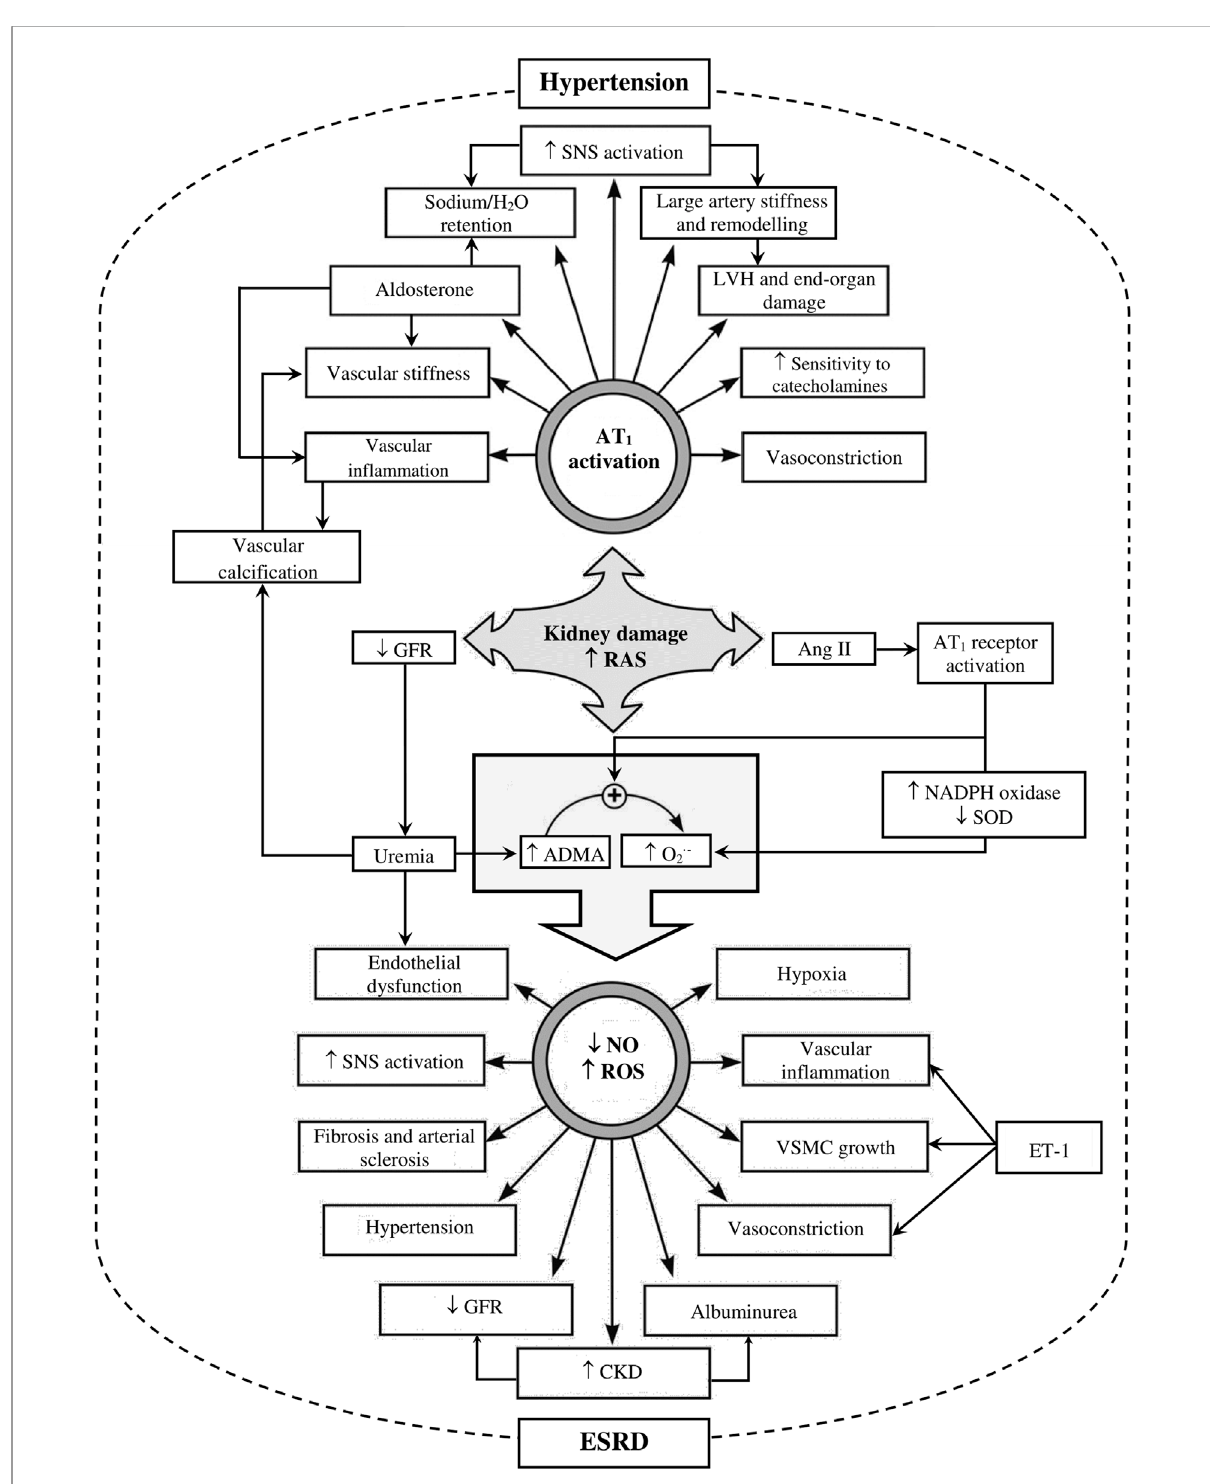
FIGURE 1 Schematic representation of factors involved in kidney damage, hypertension and end-stage renal disease (ESRD). Figure shows complications ariseuponactivation oftherenin-angiotensinsystem(RAS)secondarytokidneydamage.IncreasedRASactivitysubsequentlyactivates angiotensin- 1receptor(AT 1 receptors)viaincreasingangiotensinII(AngII)anddecreasesglomerular fi ltrationrate(GFR).Angiotensin1receptoractivationresults inamyriadofeffectssuchasvascular remodelingandin fl ammation,aldosteronerelease,sodium/H 2 Oretention,disturbsthebalancebetween antioxidant (superoxide dismutase; SOD) and oxidant (nicotine amide dinucleotide phosphate; NADPH) mechanisms, and increase sympathetic